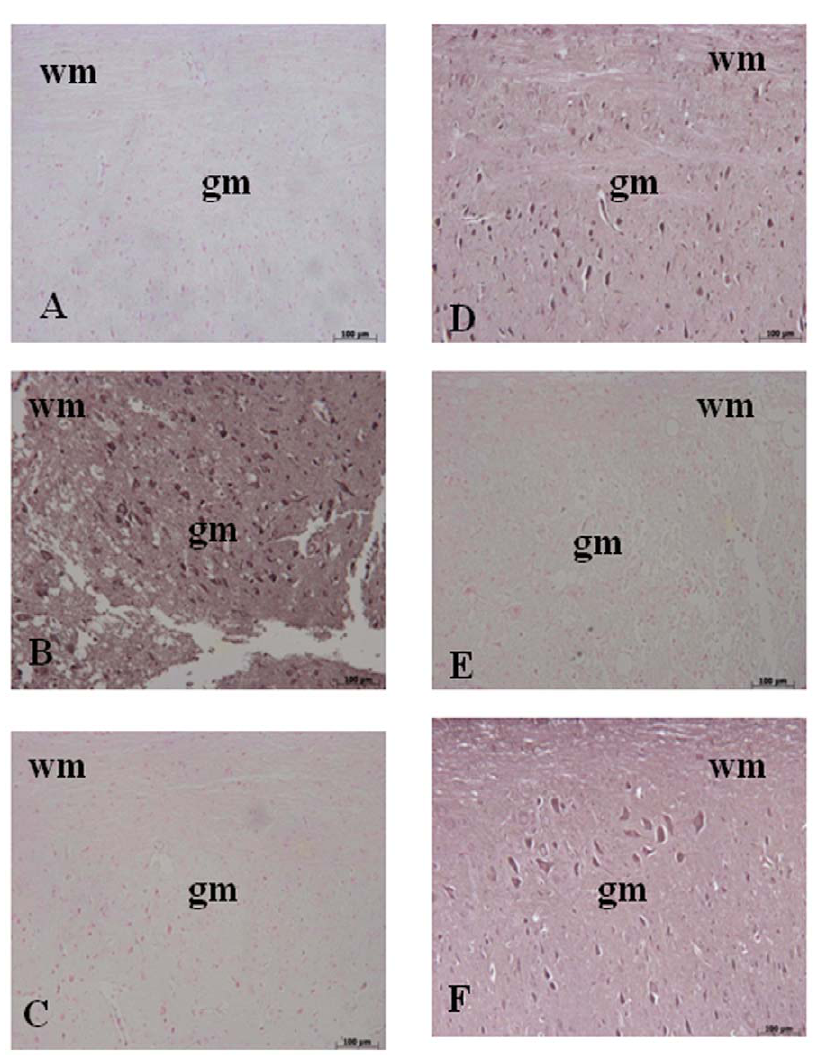
Figure 11. Effects of olprinone on apoptotic proteins. Staining for Bax expression was absent in Sham group ( A ). Twenty-four hours after SCI, spinal cord tissue from injured-animals showed a positive staining for Bax ( B ). Olprinone treatments (0,2 mg/kg) significantly reduced the SCI-induced Bax ( C ). On the contrary, positive staining for Bcl-2 was observed in the spinal cord tissues from sham-operated mice ( D ) while the staining was significantly reduced in SCI mice ( E ). Olprinone treatment attenuated the loss of positive staining for Bcl-2 in the spinal cord from SCI- subjected mice ( F ). Data are expressed as% of total tissue area.